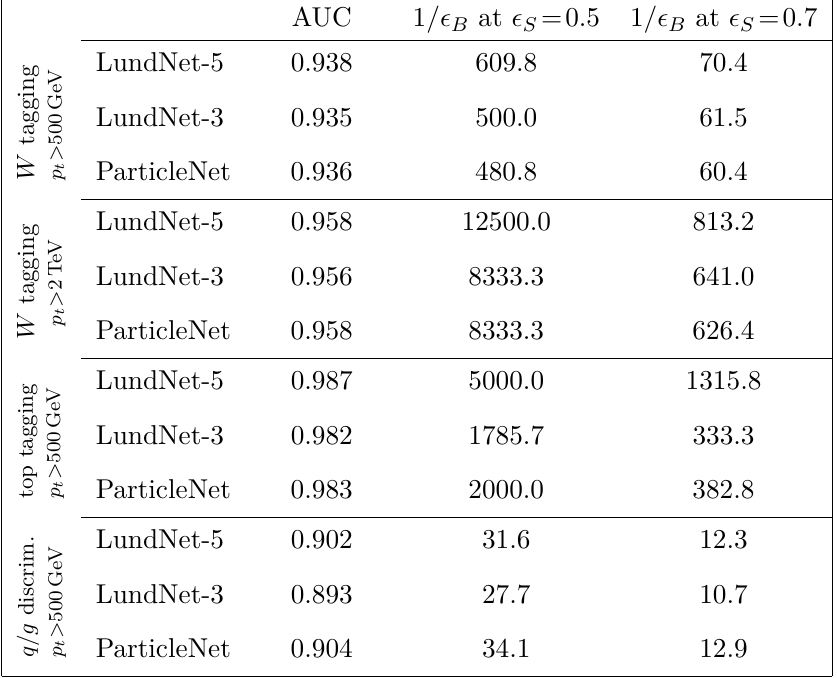
Table 1 . Benchmarks of several jet tagging algorithms for a range of processes. The first column gives the area under the ROC curve, and the later two show the background rejection at two different signal efficiencies, 50% and 70% respectively. In each case, larger values indicate better